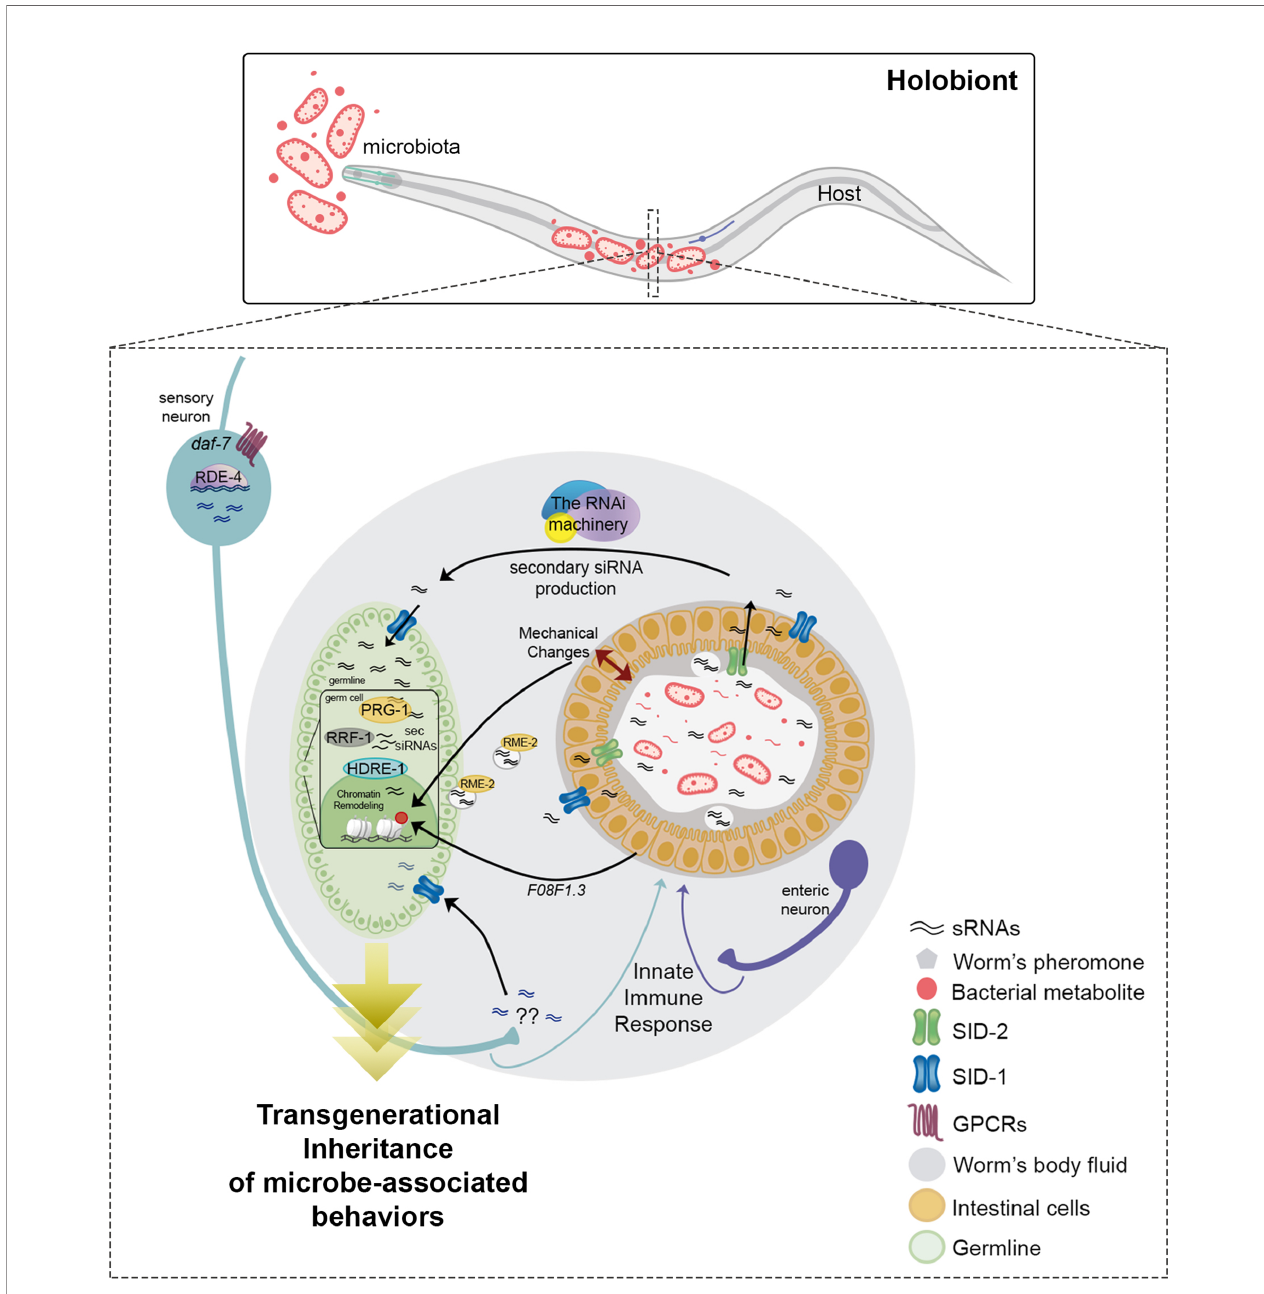
FIGURE 2 | Small RNAs regulate transgenerational inheritance of behaviors triggered by previous microbial experience in C. elegans . Neuron to-gut to-germline signaling is essential to induce the transmission of the memory of previous microbial encounters. Sensory neurons perceive bacterial metabolites through GPCRs, modulating the DAF-7/TFG- b signaling pathway. Neuronal RDE-4 is necessary for sRNA production involved in transgenerational control of behavior. Neuronal sRNAs (blue) are transferred into germ cells through the dsRNA transporter SID-1 to induce transgenerational silencing. It is still unknown how these neuronally- derived sRNAs are secreted into the worms ’ body. Sensory neurons (light blue) and neurons adjacent to the intestine (enteric; purple) control intestinal immunity against pathogens. Whether intestinal responses triggered by bacteria drive sRNAs changes is not known. Bacterial (pink) and host (black) sRNAs are transported from the lumen to the intestine through SID-2 and systemically through SID-1. RME-2 mediates the endocytosis of sRNAs from the worms ’ cavity to oocytes. The RNAi machinery ampli fi es sRNAs causing transgenerational silencing. In the germline, the Piwi protein PRG-1, the RNA helicase RRF-1, and the nuclear Argonaute HDRE-1 are essential for driving transgenerational changes by epigenetic modulation. The transmission of epigenetic information between intestine and germ cells is mediated by the transcriptional regulation of F08F1.3. Mechanical changes in the intestine triggered by bacterial colonization may induce intergenerational histone acetylation in the